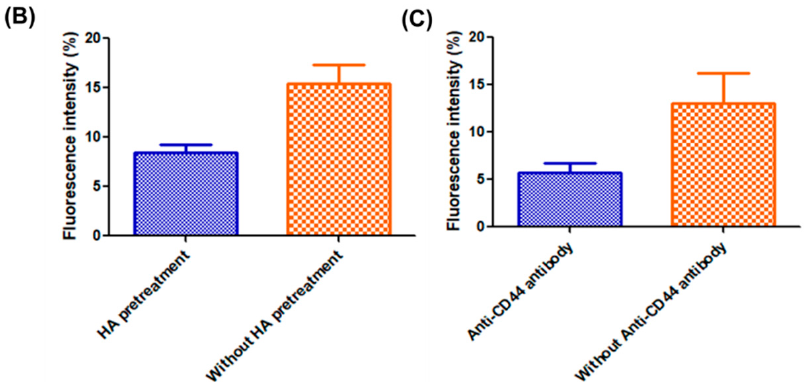
Figure 9. Cellular uptake study of T GNC-DOX in MDA-MB-231 cells. ( A ) CSLM images showing cellular uptake of T GNC-DOX followed by with or without HA pretreatment and after with and without blocking with anti-CD44 antibody (scale: 25 µ m). ( B ) Bar graph showing percentage fluorescence intensity DOX with or without HA pretreatment. ( C ) Bar graph showing percentage fluorescence intensity DOX with or without anti-CD44 antibody pretreatment.